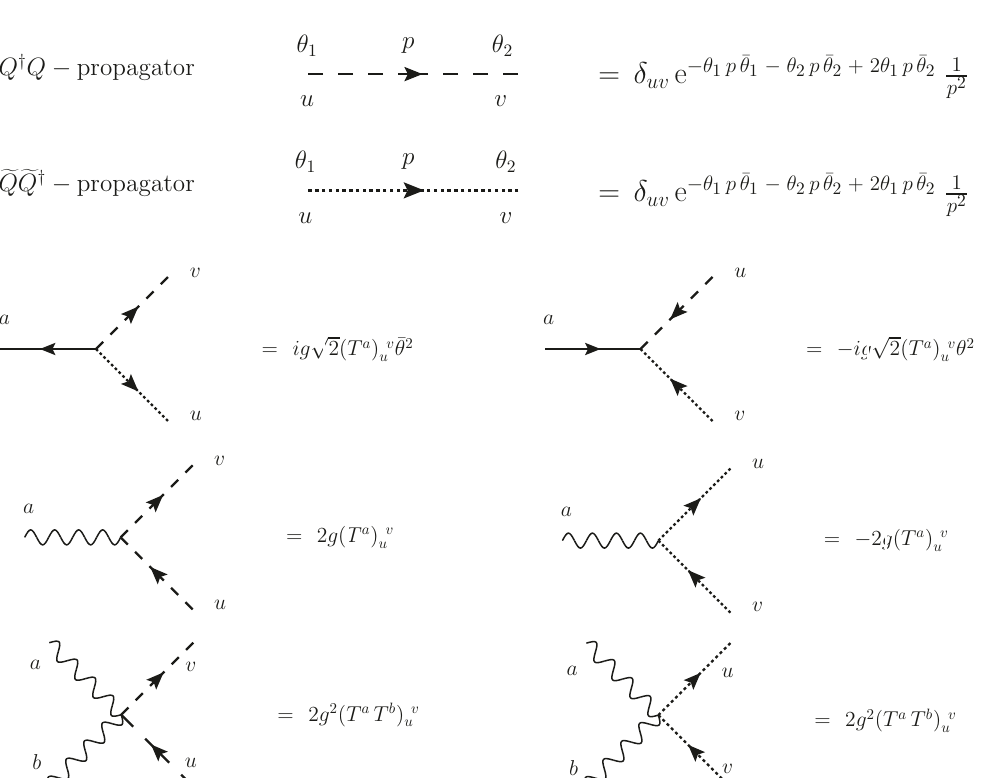
is the adjoint representation. In terms of R